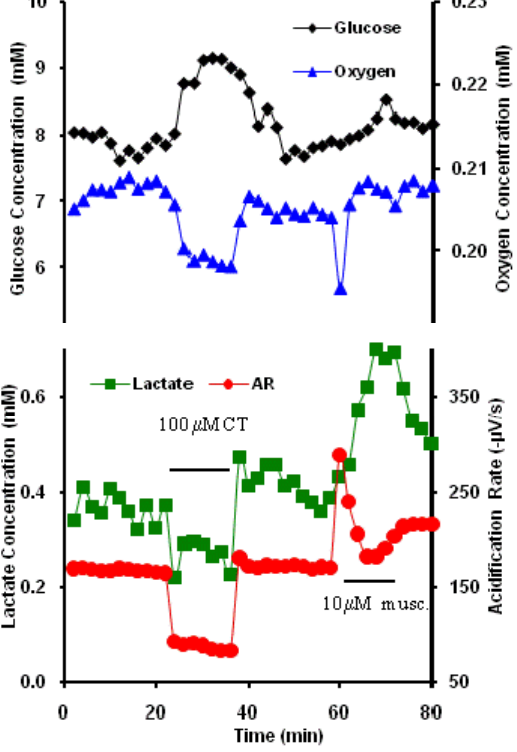
Figure 5. Representative CHO cell response to 1  M cholera toxin followed by stimulation with 10  M